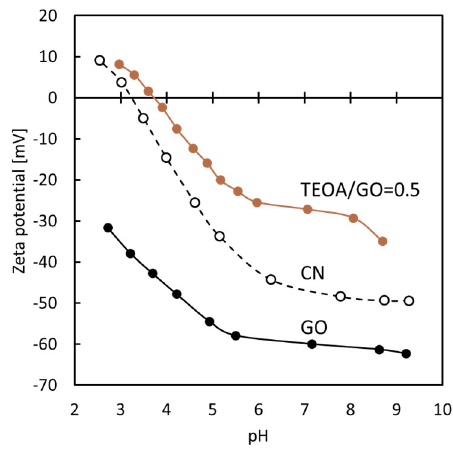
Figure 6. Zeta potential of the GO membrane, GO-TEOA membranes fabricated with TEOA/GO = 0.5 and the cellulose nitrate support membrane.